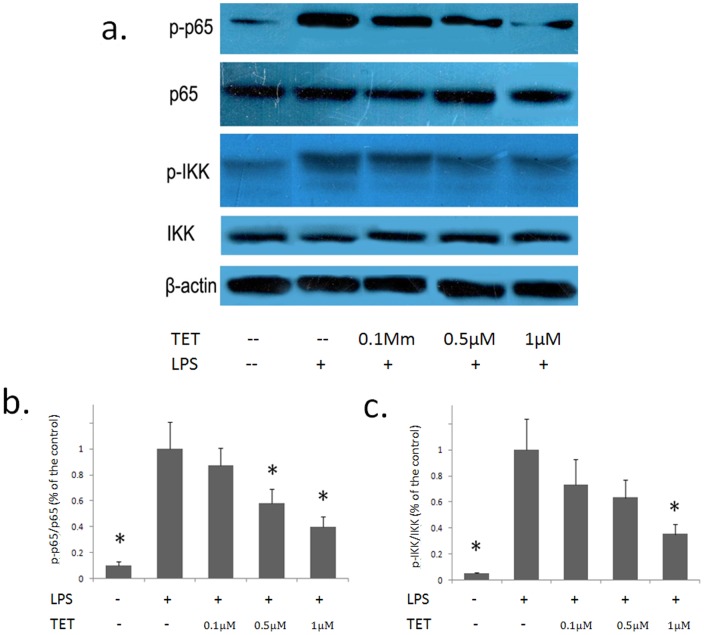
Effect of TET on LPS-stimulated NF-κB activity in BV2 cells.BV2 cells were treated with TET at working concentrations for 2 h. Then, LPS was added to each plate and incubated at 37°C for an additional 24 h. Then, the cells were lysed for protein extraction. Fig. 6a: p-p65, p65, p-IKK, IKK, and β-actin expression were measured by Western blotting analysis. Fig. 6b–6c: The ratio of densitometry values of total and phosphorylated protein was normalized to each respective control group. β-actin was applied as the internal control. Results were the mean ± S.D. from three independent experiments performed in triplicate. * P<0.05 compared with the LPS group.